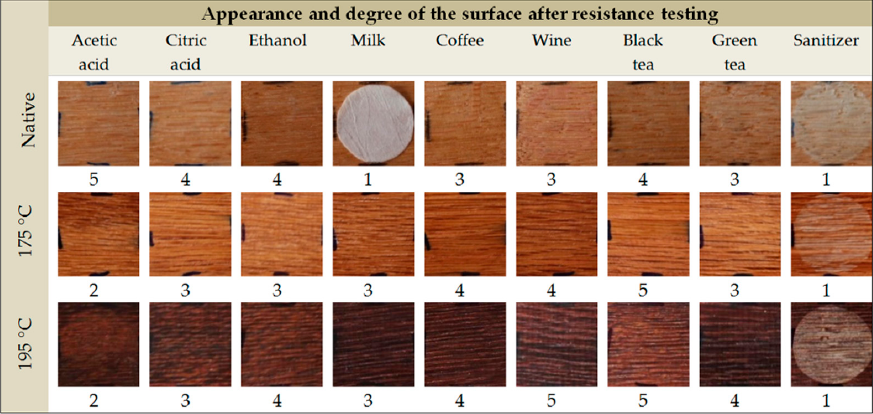
Figure 8. Resistance to cold liquids (degree): surface finish of linseed oil + oil.